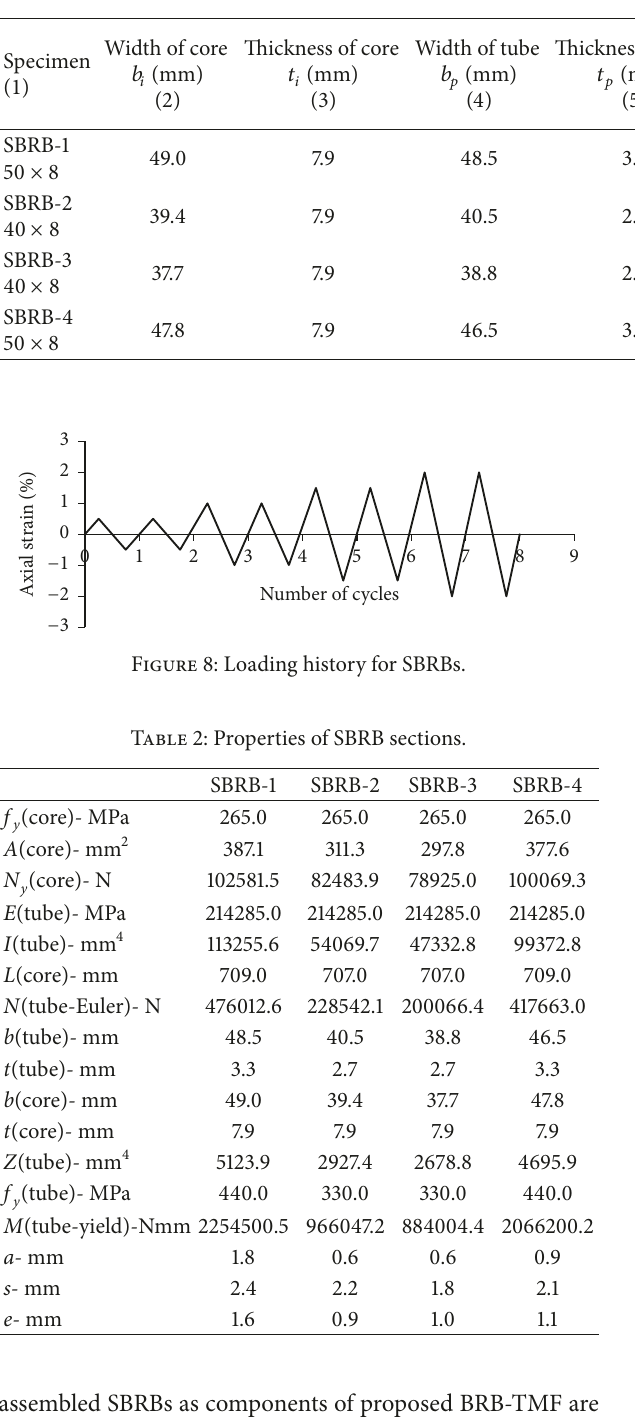
Table 1: Dimensions of SBRBs from the design.